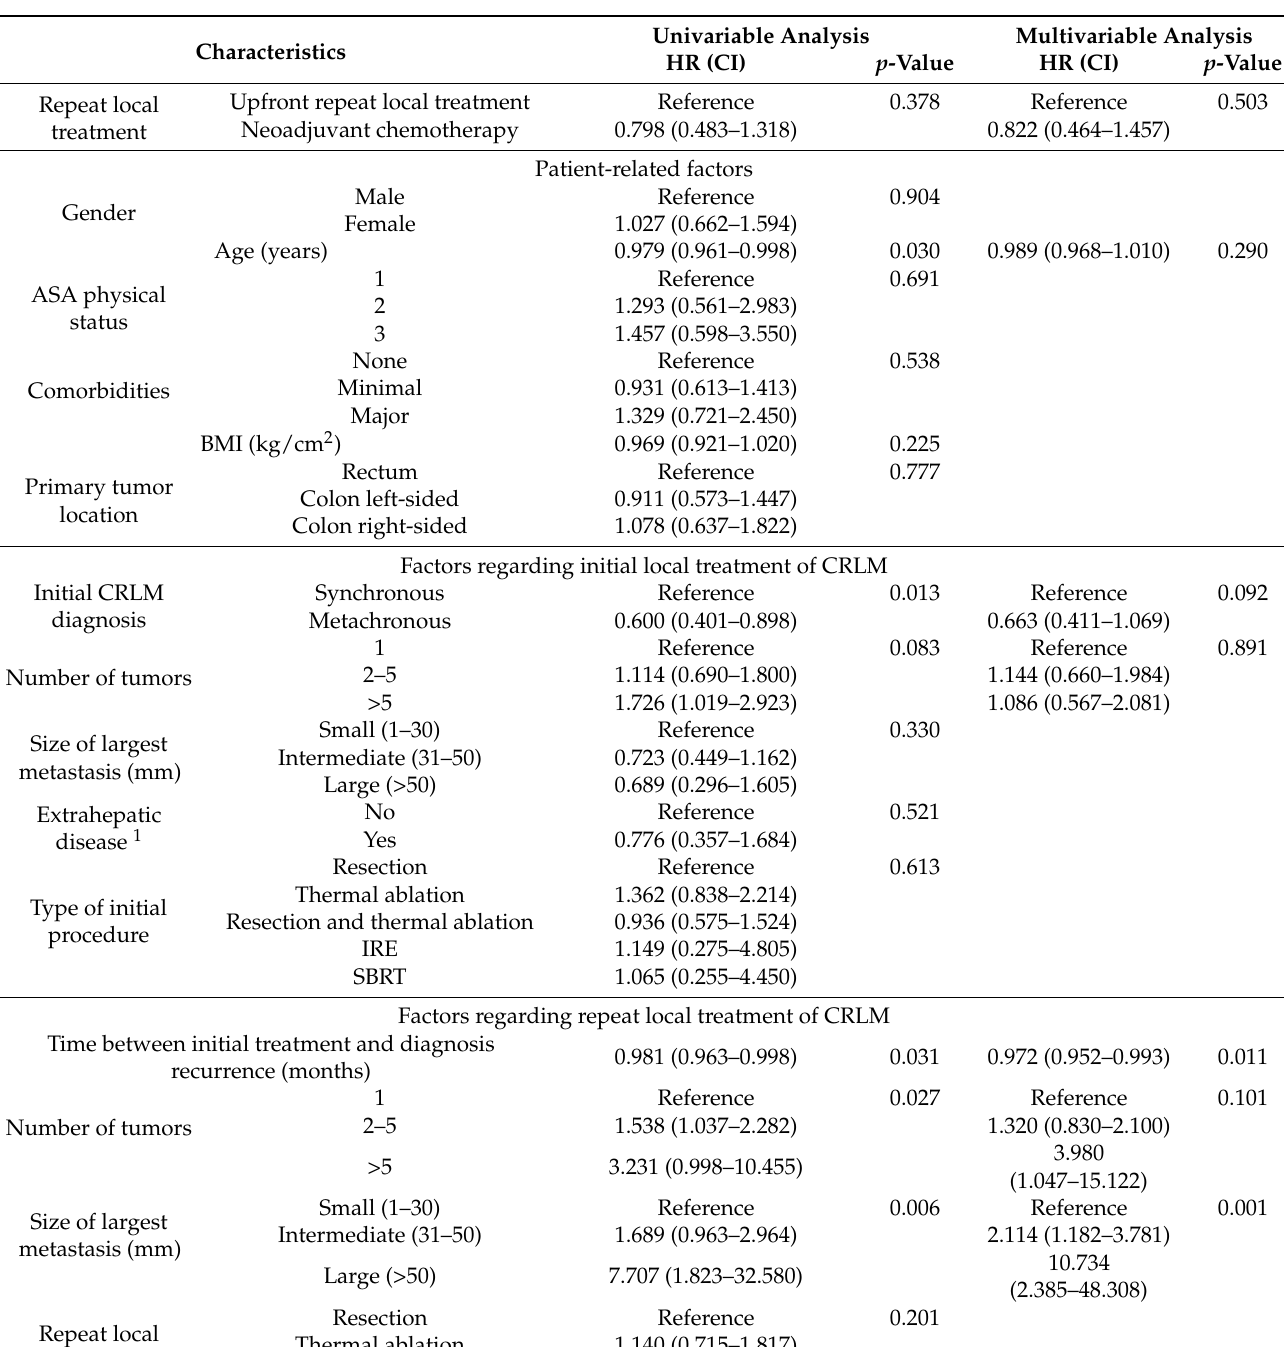
Table 8. Univariable and multivariable Cox regression analysis to detect potential confounders associated with distant progression-free survival (DPFS). The association between the two treatment groups and DPFS did not differ >10% in the corrected model. Therefore, age, initial CRLM diagnosis, initial number of CRLM, time between initial treatment and diagnosis recurrence, number of recurrent metastases, and size of largest recurrent metastasis were removed. HR of repeat local treatment was 0.798 (95% CI, 0.483–1.318; p =